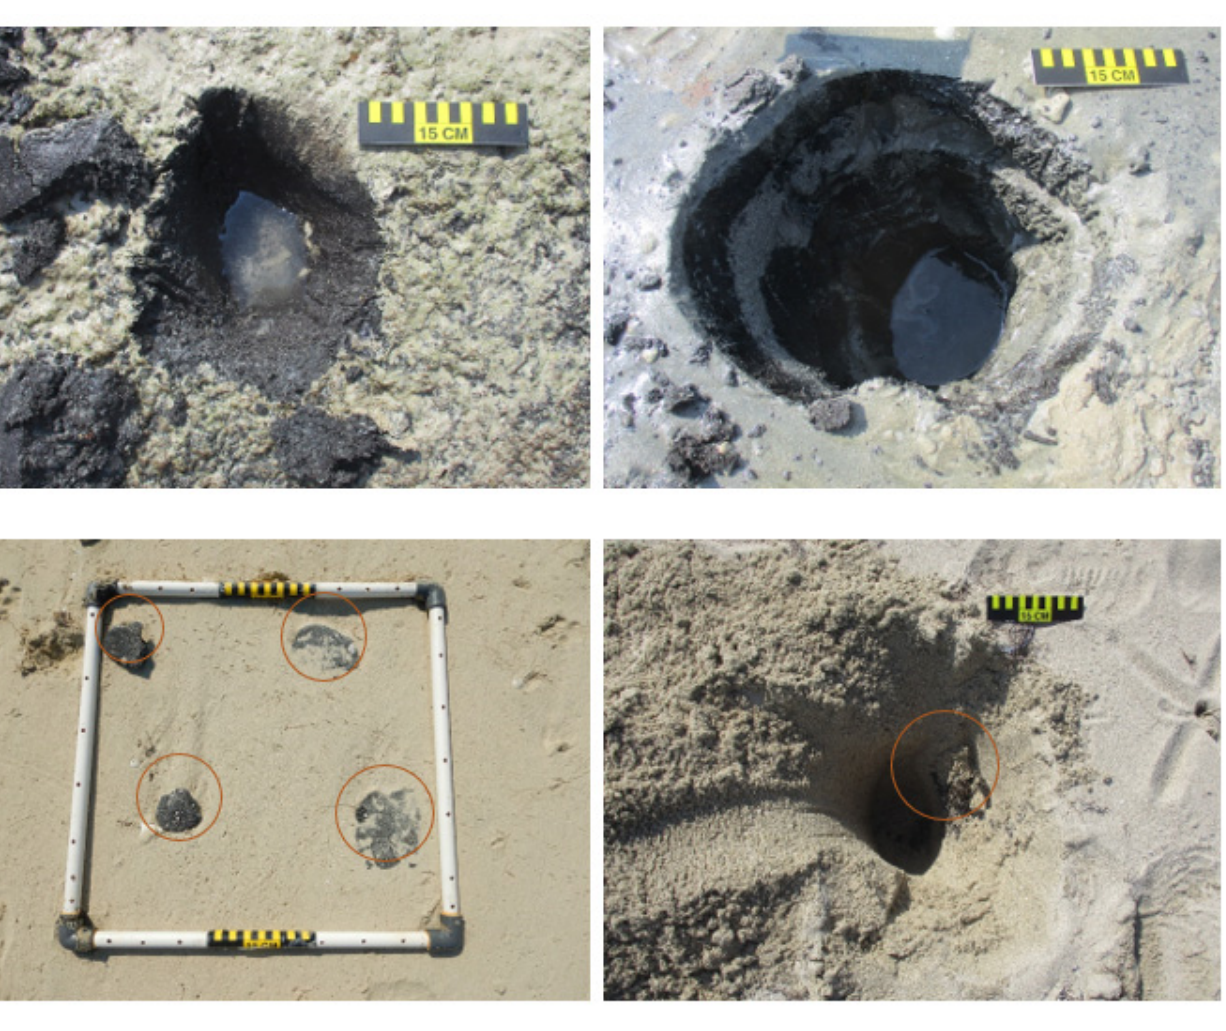
Figure 3. Observed oiling: asphalt pavements exposed at the surface (top left) and buried in the subsurface (top right); tarballs exposed at the surface (bottom left) and buried in the subsurface (bottom right). Individual tarballs identified with red circles.